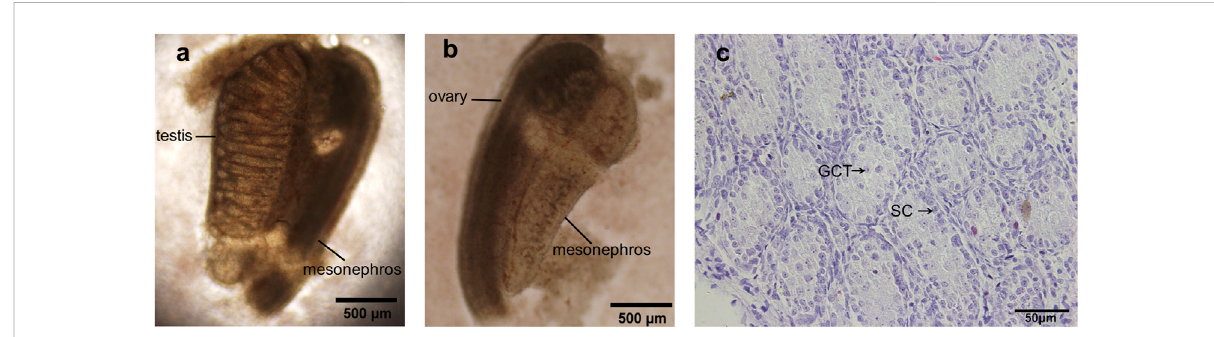
FIGURE 1 15.5 dpc fetal testis preparation and identi fi cation. (A) The testis was rounder than ovary and contained a testicular vessel; (B) Ovary was relatively longer and spots were visible under anatomic microscope; (C) H&E staining of dpc 15.5 fetal testis, intact seminiferous tubules with no lumen were present, gonocytes and Sertoli cells were normally displayed. GCT, gonocytes; SC, Sertoli cells. (A,B) ×100 magni fi cation, scale bars indicate 500 μ m, (C) ×400 magni fi cation, scale bars indicate 50 µm.